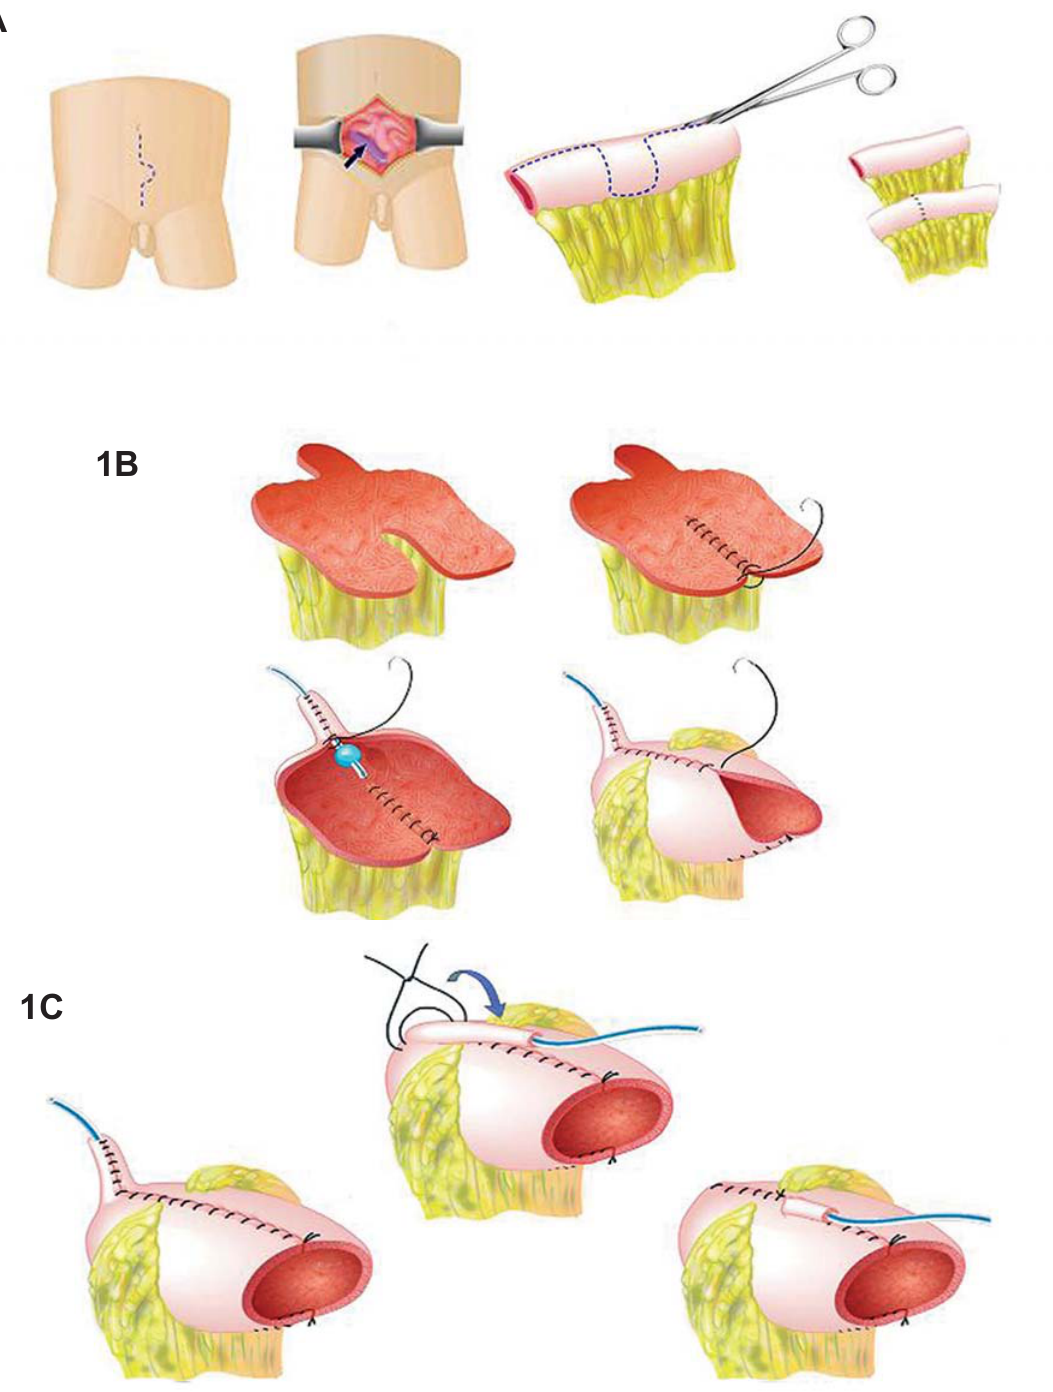
Figure 1 – Macedo’s continent catheterizable reservoir - surgical technique. Reproduced from Macedo A. Jr., Srougi M.: A continent catheterizable ileum-based reservoir. BJU Int. 2000; 85: